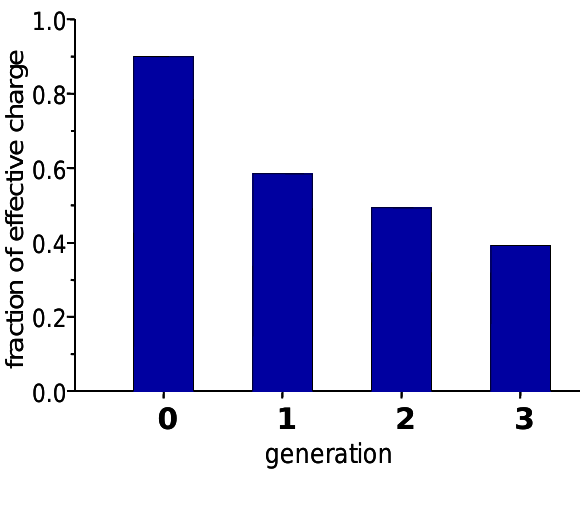
Figure 5. Fraction of effective charge of fully protonated PAMAM dendrimers as a function of their